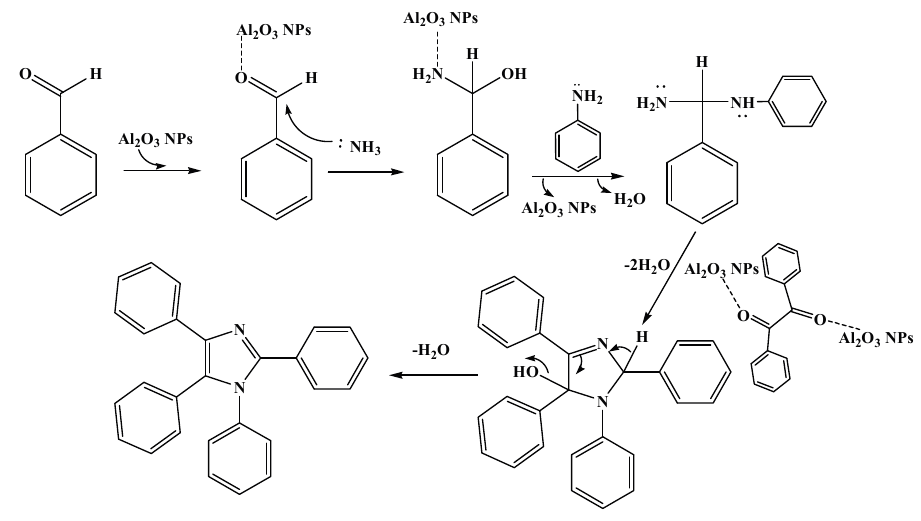
Figure 4. Plausible mechanism for synthesis of tetraaryl imidazoles.